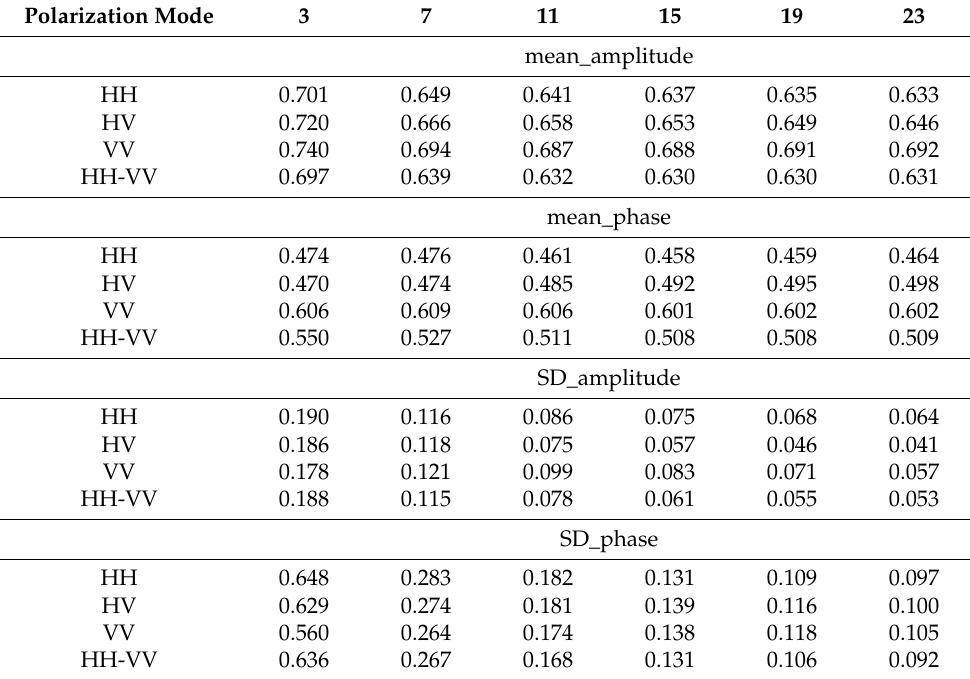
Table 4. The mean and SD of coherence amplitude and phase for different statistical window size in